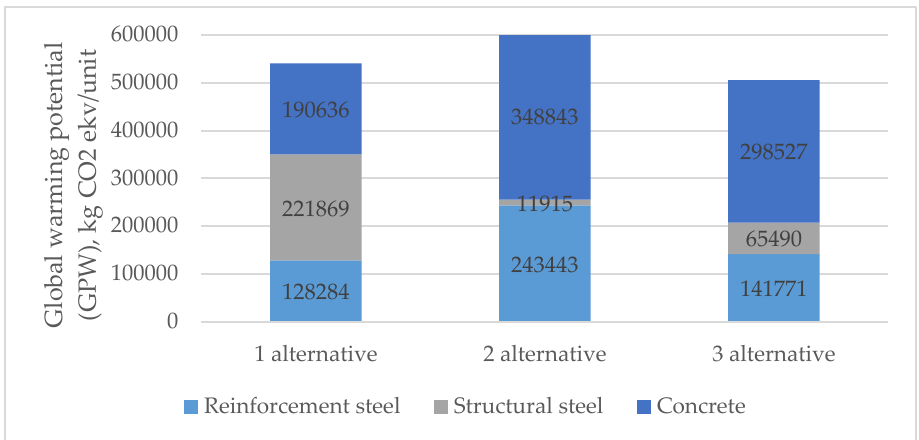
Figure 13. Comparison of global warming potentials (GWP, kg CO2 eq). Table 5. Comparison of ozone depletion potentials (ODP, kg CFC-11 eq).